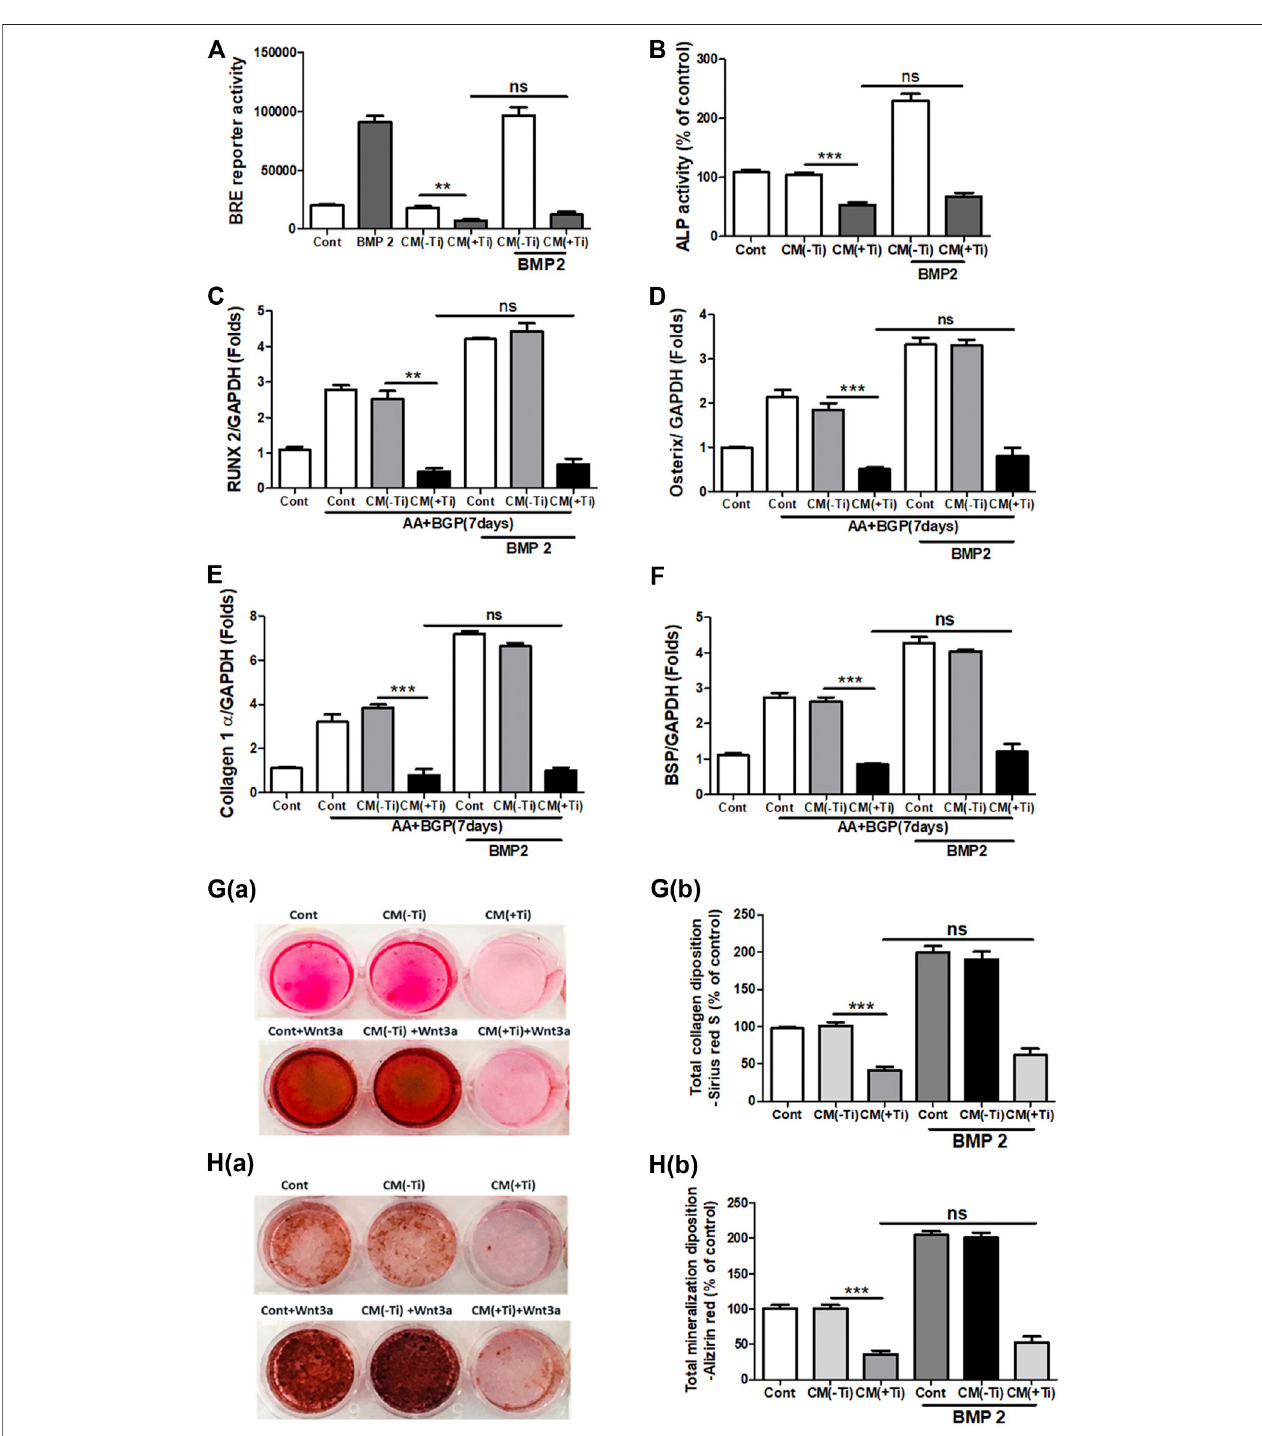
FIGURE6| TiCMinhibitsosteogenicinductionafterstimulationofosteoblastsbyexogenousBmp-2.TheSaOS-2cellwaspre-incubatedwiththeTiCMfor30 min andthereafterstimulatedwithrecombinantBmp-2alongwiththeTiCM. (A) CelllysatesfromTiCM – treatedSaOS-2cells(Axin-2reporterconstructtransfected)for24 h werecollected,andreporteractivitywasanalyzed. (B) ALPassaywasperformedafter48 hoftreatment. (C – F) SaOS-2cellsweregrownunderdifferentiationconditions asdescribed in MaterialsandMethods for7 days (D) andthentreatedwith100%TiCMalongwithBmp-2for24 h.RelativemRNAexpressions ofOsterix,Runx2, collagen1 α ,andBSPwereevaluatedbyreal-timePCR.TheresultsshownarenormalizedtoGAPDHlevels. (G) Collagensynthesisand (H) mineralizationwereevaluated after 14 days of treatment by Sirius Red and Alizarin Red S staining, respectively. (G(a)) Collagen deposition gross appearances. (G(b)) Quantitative analysis of Sirius Red S staining. The effect of Ti CM on mineralization is depicted as (H(a)) gross appearances. (H(b)) Quantitative analysis of Alizarin Red S staining. Data are shown as mean ± SD. Similar results were obtained in three independent experiments. * p < 0.05, ** p < 0.01, ***, p < 0.001, and ns (no signi fi cance) vs. control.